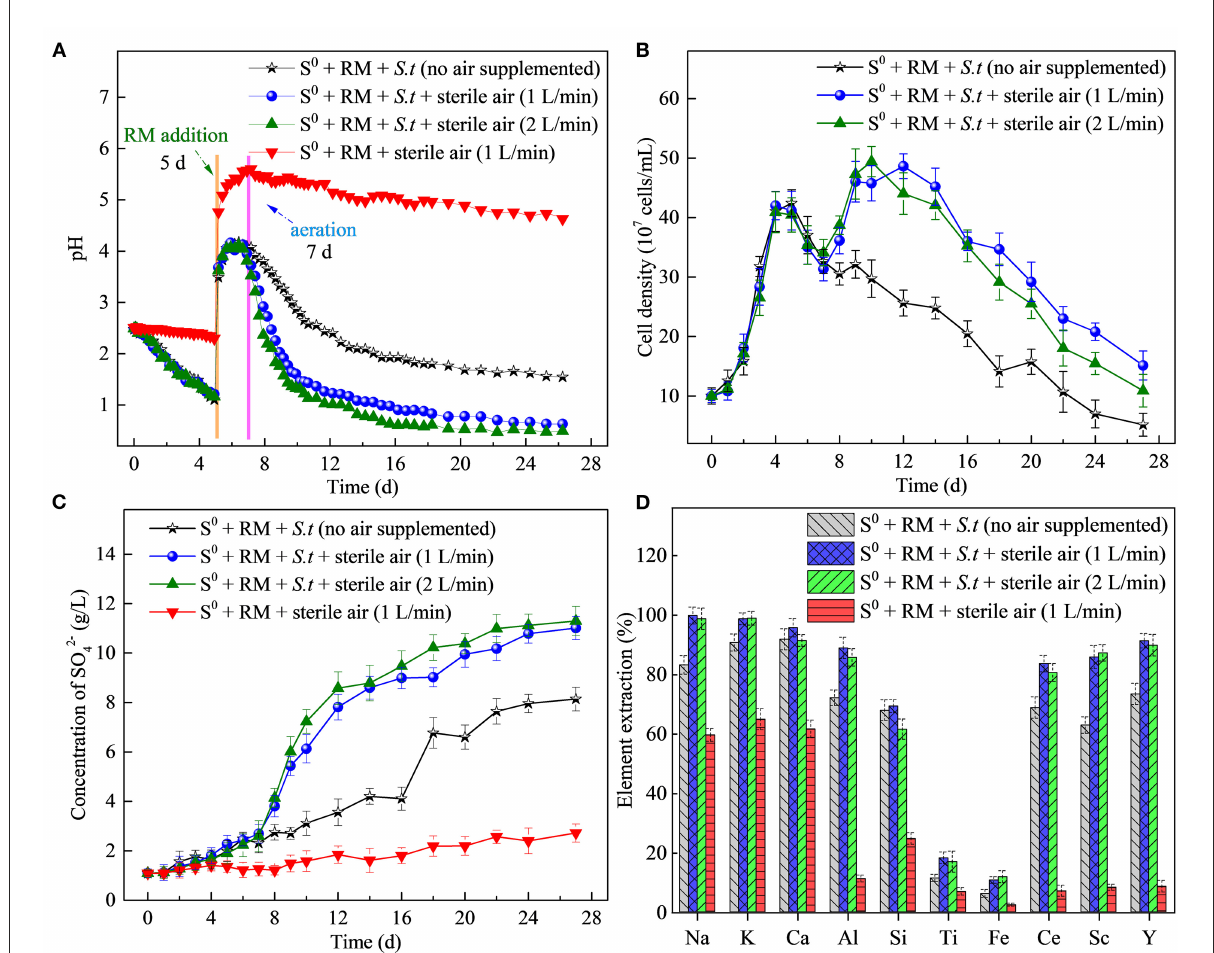
FIGURE7 Effects of the aeration rate on RM bioleaching process kinetics. Changes in (A) pH, (B) planktonic cell counts, (C) concentration of SO 2 − 4 , and (D) percentages of elements extracted from RM. Bioleaching by Sb. thermosulfidooxidans ( S.t .) was conducted for 27 days in a 5-L STR with the S 0 /RM mass ratio of